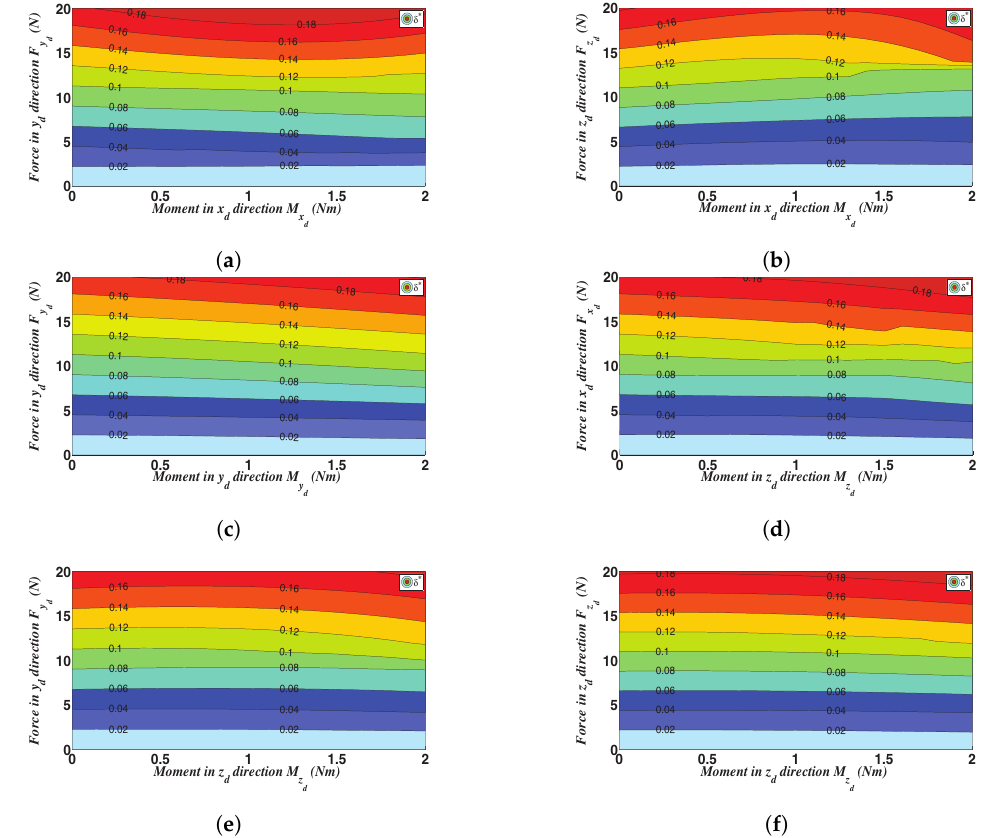
, and force, F y ; ( b ) moment, d d , and force, F x ; ( e ) moment, M z d d